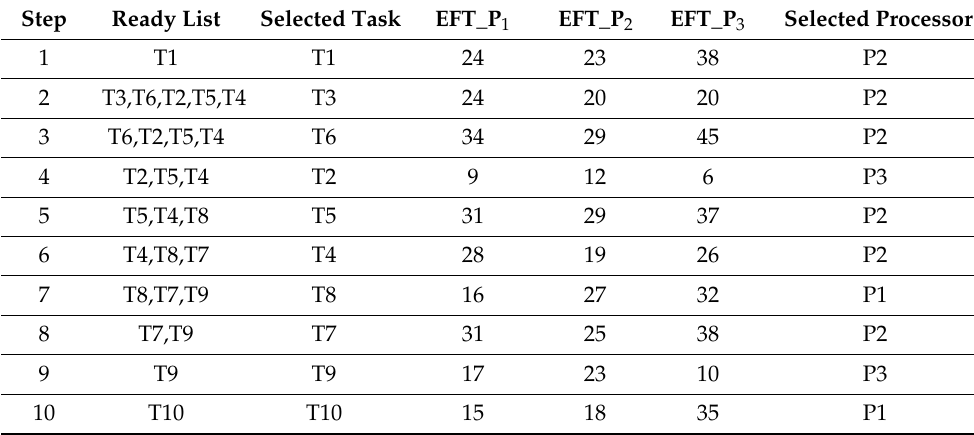
Figure 5. Average schedule lengths ratio for the montage workflow. Table 2. Selection of task and processor in each iteration of the